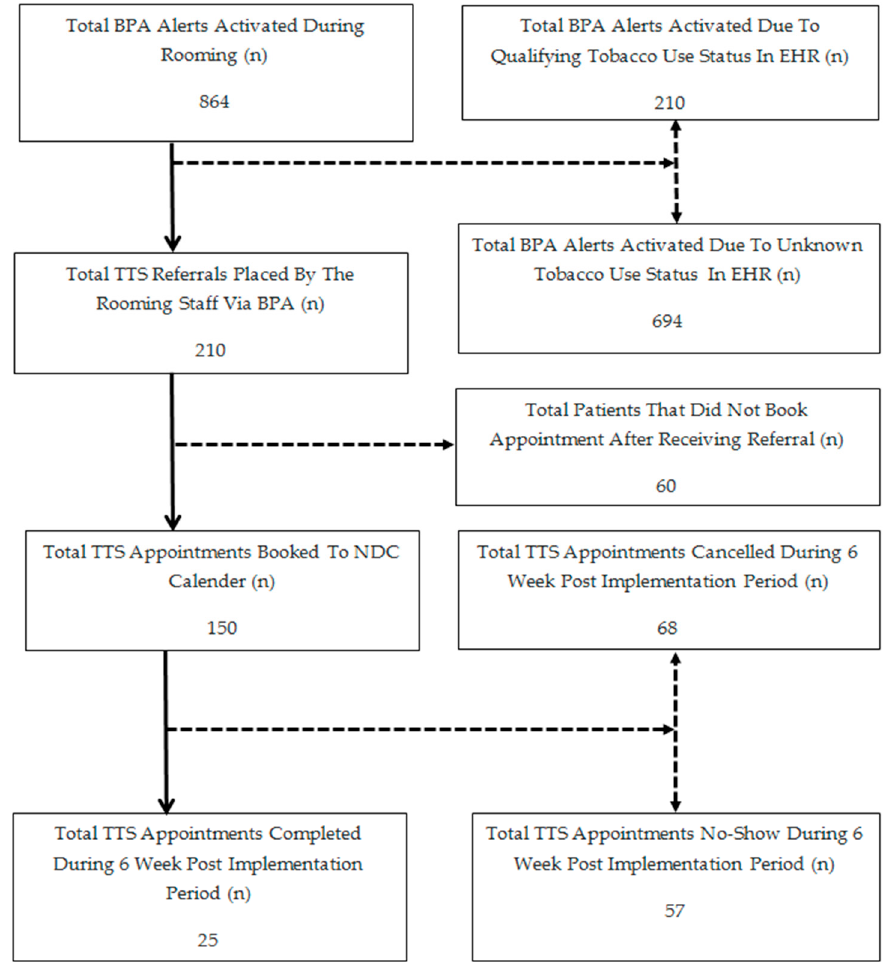
Figure 2. Outcomes of electronic health record (EHR) based best practice advisory (BPA) alerts and tobacco treatment specialist (TTS) appointments for the first six weeks of implementation in the Division of Medical Oncology, Rochester, MN. Values are the number of patients in each category over this period of time. NDC, Nicotine Dependence Center, Rochester, MN.